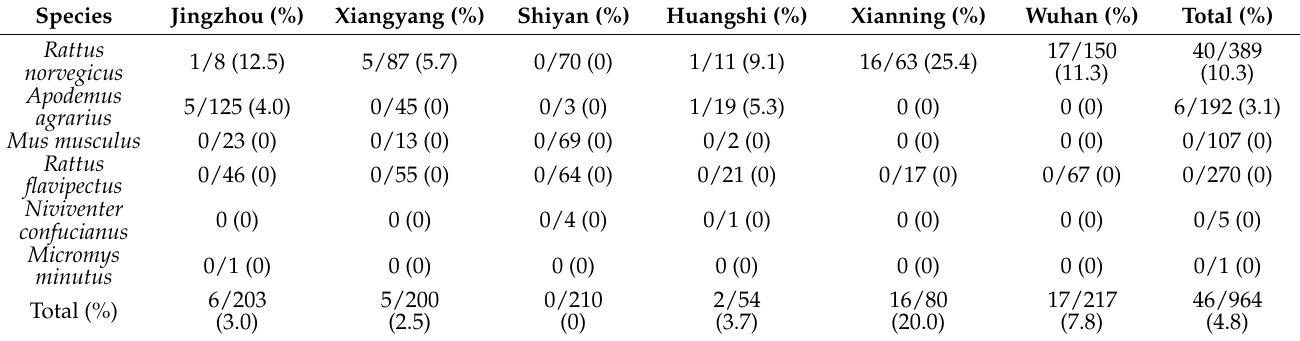
Table 1. Prevalence of pathogenic Leptospira according to locality and rodent species in